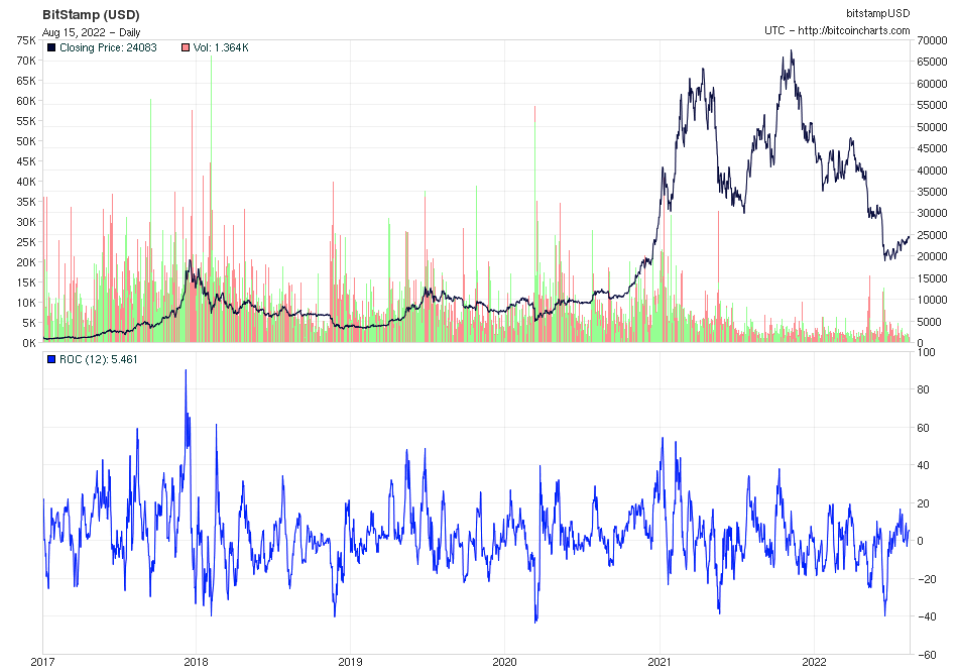
Figure 1. Price in US Dollars and the rate of change evolution from 2017 to the